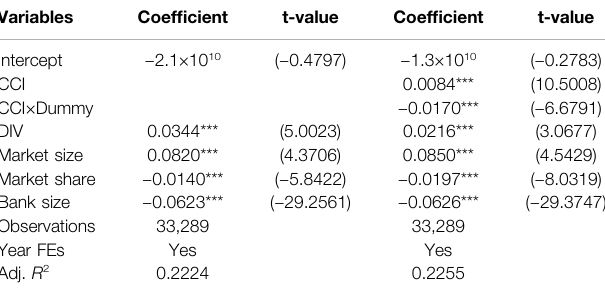
TABLE 1 | The effect of diversi fi cation and network centrality on bank